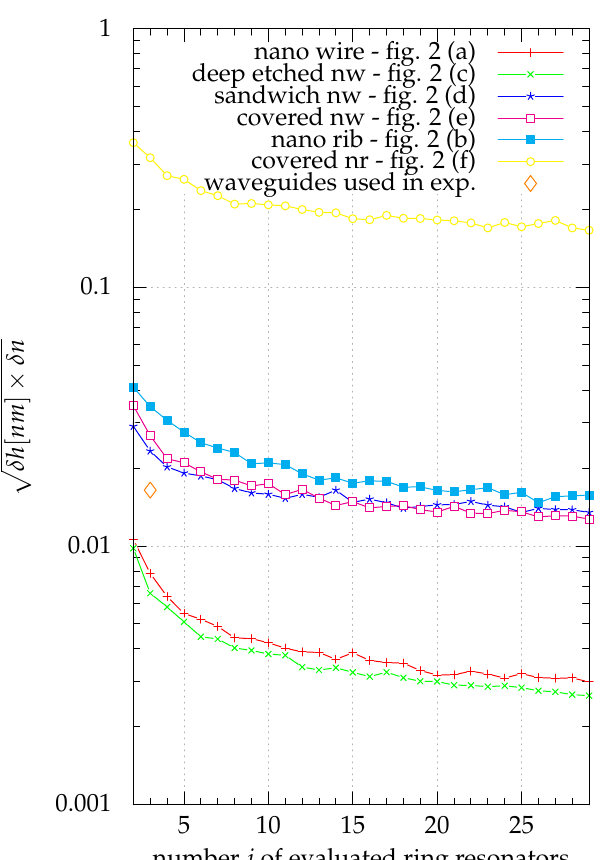
Figure 5. The geometrical mean of the precision in refractive index and in layer thickness (in nano meters) as a figure of merit for the sensor system is plotted over the number of different waveguides used for different waveguide geometries. The only uncertainty considered is the wavelength accuracy of the resonance wavelengths. Production errors for the geometrical waveguide properties are neglected to show the theoretical limitations of the method. When not all waveguide widths were used, the combination with the lowest figure of merit was